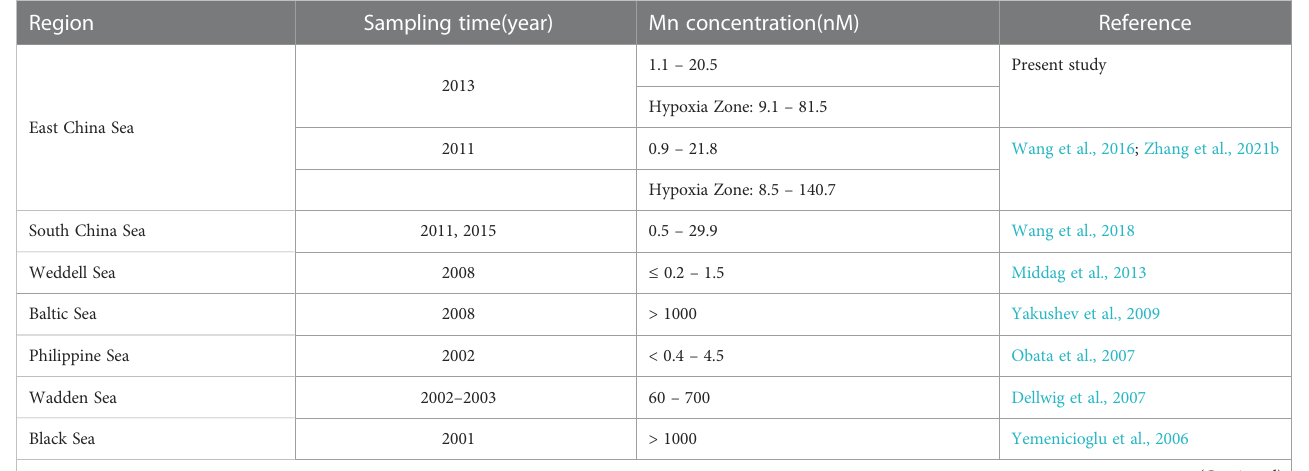
TABLE 1 Comparison of dissolved manganese concentrations in ECS with global marginal seas.